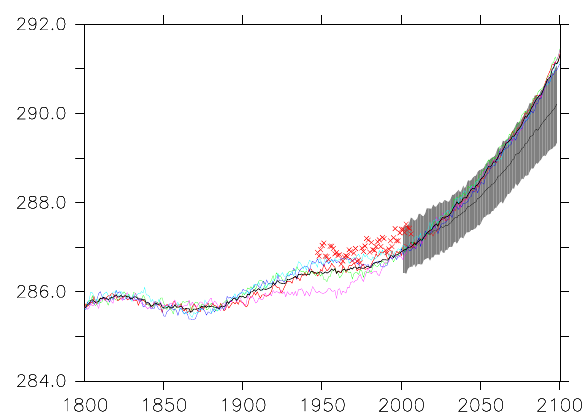
Fig. 19. The annual global mean two meter temperature in K from 1800 to 2100 in each of the SPEEDO ensemble members (thin red, green, light blue, blue and purple lines) and the ensemble mean (thick black line). Also shown are the reanalysis data from 1950 to 2008 (red crosses) and the multi-model ensemble mean two meter temperature of all SRES A2 CMIP3 simulations (thin black line). The one standard deviation spread in the CMIP3 ensemble is shown in gray.